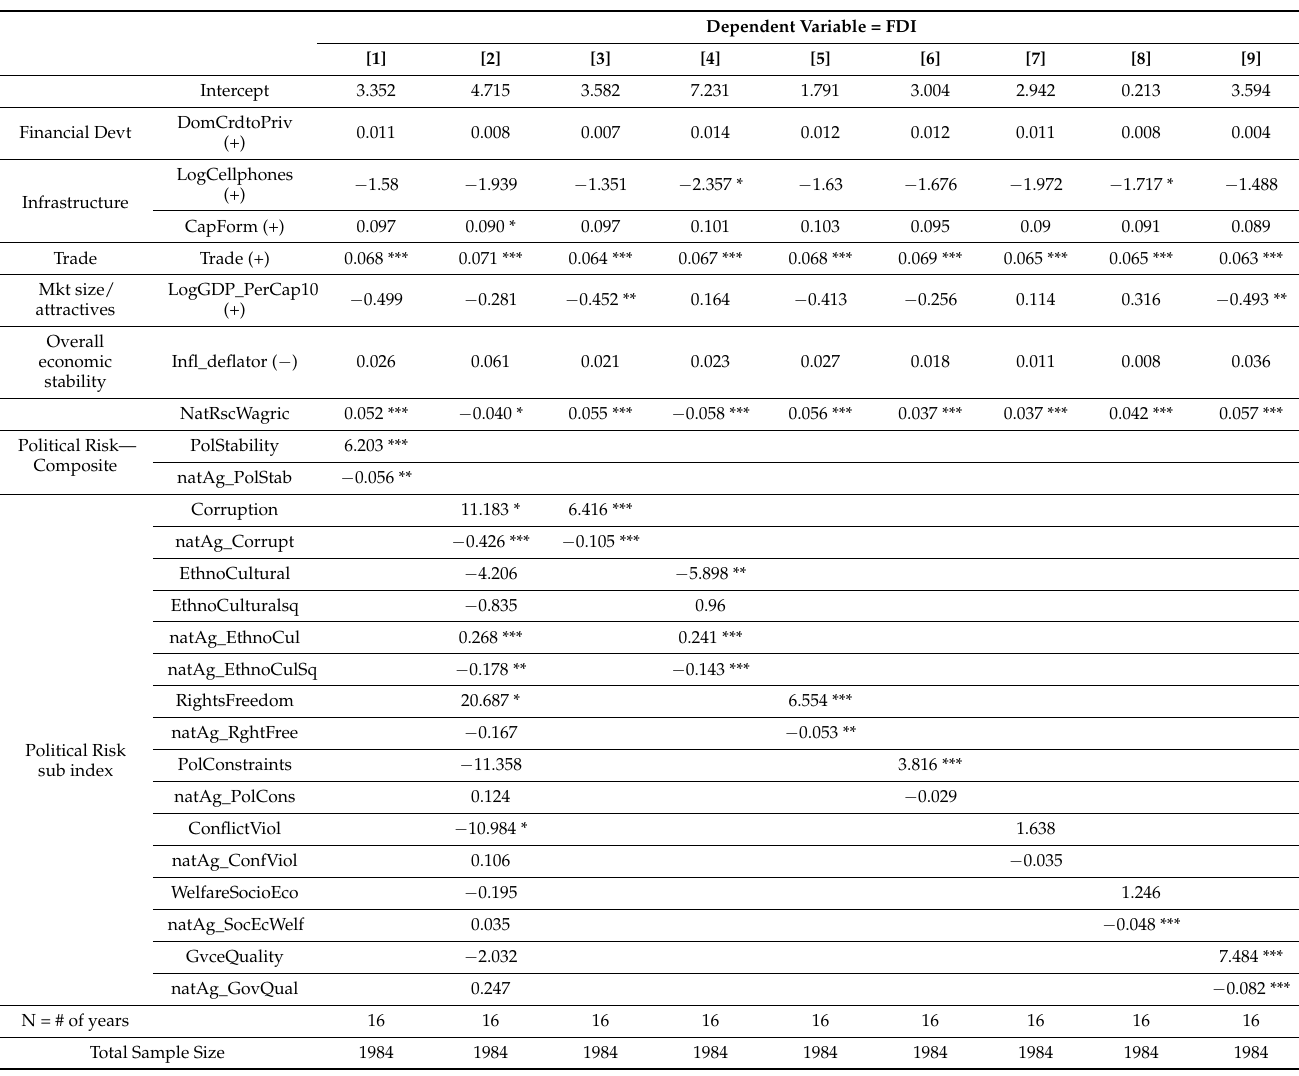
Table 4. Political Risk, Natural Resources, and